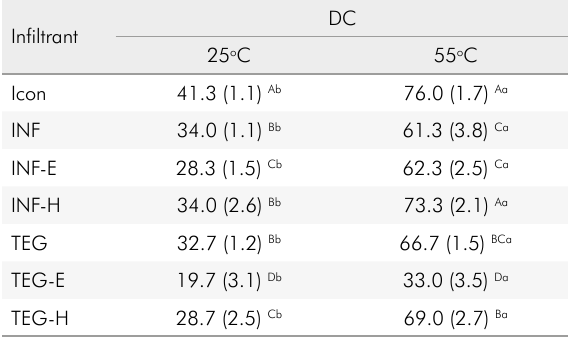
Table 2. Mean values of degree of conversion (%) of infiltrants, according to